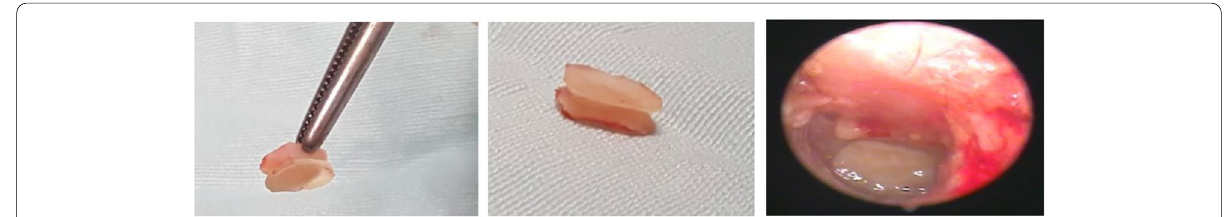
Fig. 1 Preparation and positioning of inlay butterfly tragal